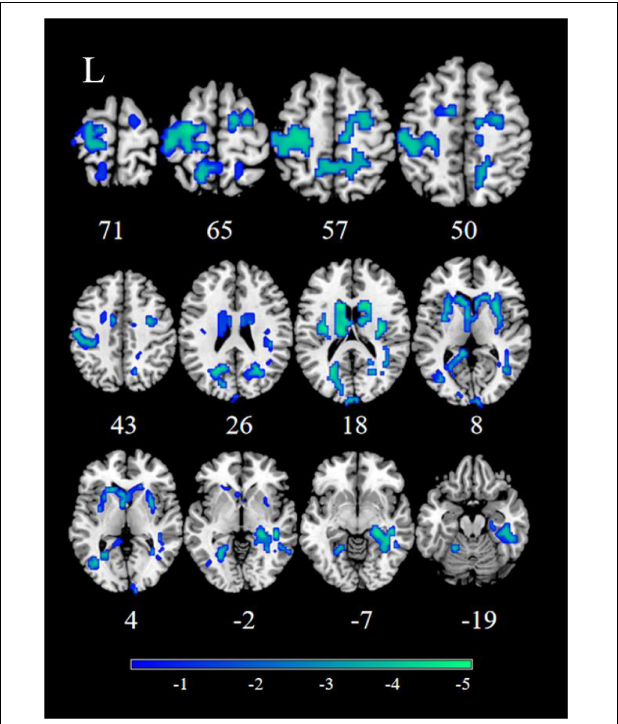
FIGURE 1 | Significant decreased resting-state functional connectivity (RSFC) of the right nucleus accumbens (NAc) in patients, compared with healthy controls (HCs). The blue regions in the brain slices present the location of difference (GRF corrected).